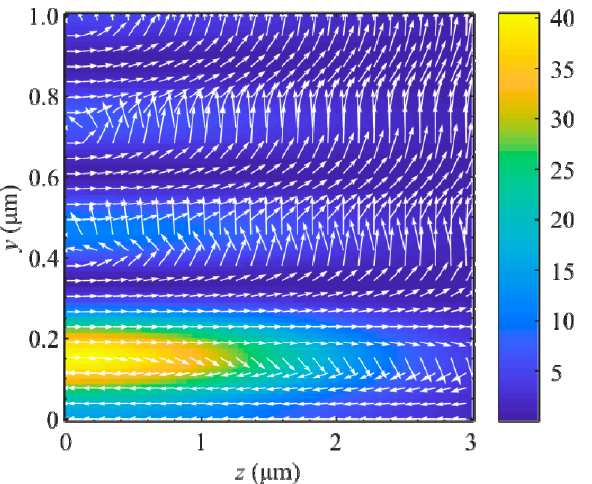
Figure 2. Intensity and direction of the Poynting vectors in the YZ-plane of the focused CVB of second order using a lens with numerical aperture NA = 0.99, limited by a narrow annular aperture with α min = 0.9 × α max .